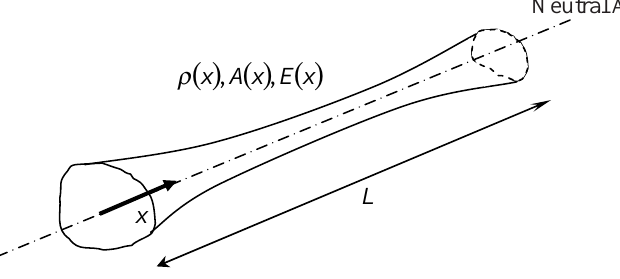
Fig. 1. Rod with variables cross section and variable material